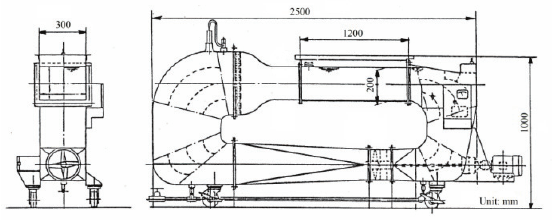
Fig. 1. Schematic diagram of closed circuit water channel .